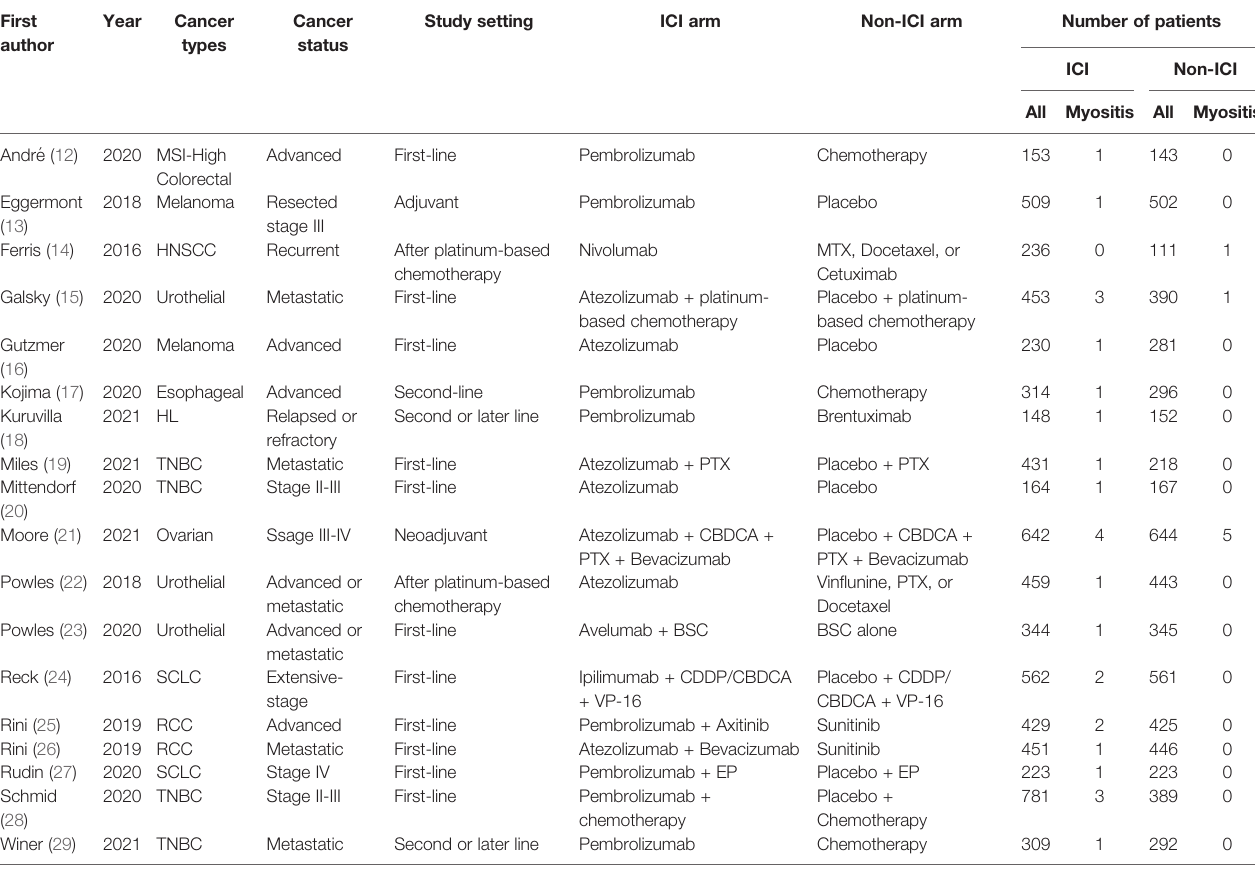
TABLE 1 | Overview of the included studies in the